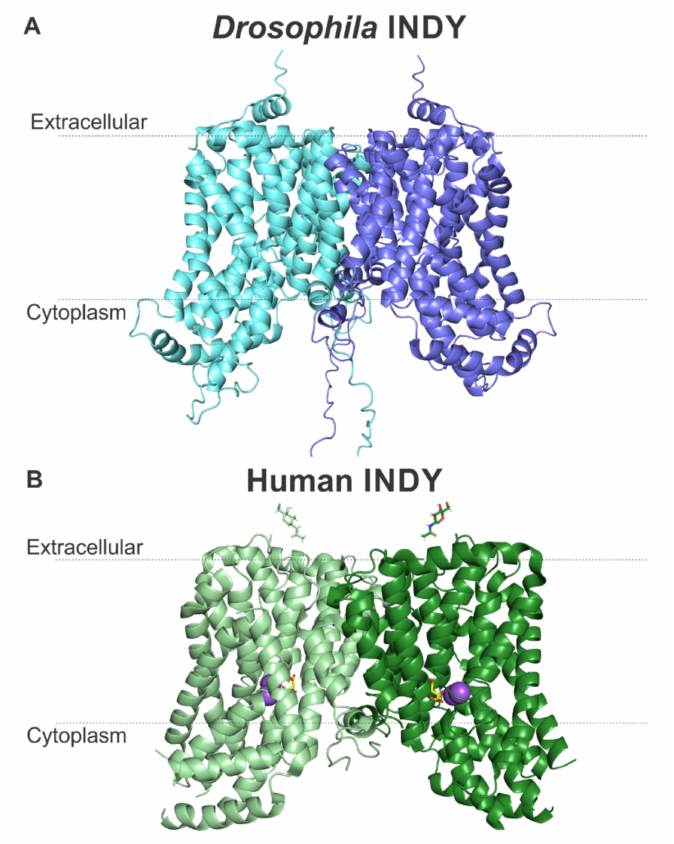
Figure 4. Inward-facing models for Drosophila INDY and human INDY (NaCT). ( A ) The 3D model for Drosophila INDY, created with AlphaFold, shows an inward-facing conformation dimer. The N-terminal extensions are extensive and are predicted as largely unstructured and located in the cytoplasm. Drosophila INDY is larger than human INDY and shows a C-terminal α -helix located at the extracellular side, which is not evident in human INDY. The N-terminus is predicted to reside on the cytoplasmic side and the C-terminus in the extracellular side; ( B ) the cryo-EM dimer structure of human INDY in an Inward- facing conformation. Na + ions are shown as purple spheres and citrate as yellow